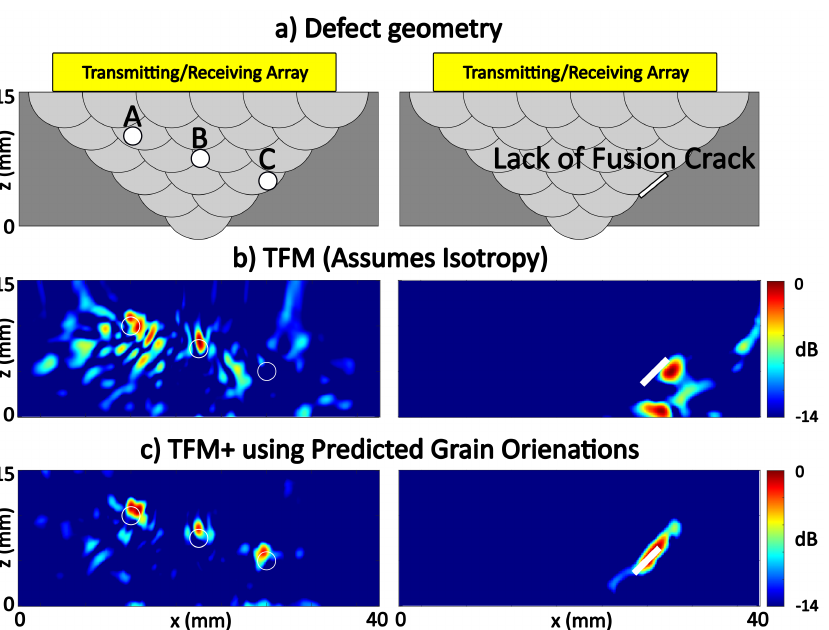
Figure 9. ( a ) Schematics of the FEA simulations using the pulse-echo transducer array configuration of a weld region parameterised with the Test Model 1 grain orientations shown in Figure 6. On the left: three circular defects (labelled A, B and C) with 2 mm diameter are embedded within the weld. On the right: the model is embedded with a crack with length 4 mm and angled at 45 ◦ to simulate a lack of fusion defect at the parent weld interface. Image ( b ) arises from the application of the TFM algorithm in which a constant wave speed is assumed throughout the domain. Image ( c ) uses the TFM+ algorithm, exploiting the predicted grain orientations arising from application of the DNN to the FEA data generated by simulation of the pulse-echo inspection as depicted in Figure 8. The known boundaries of the defects are represented by the white